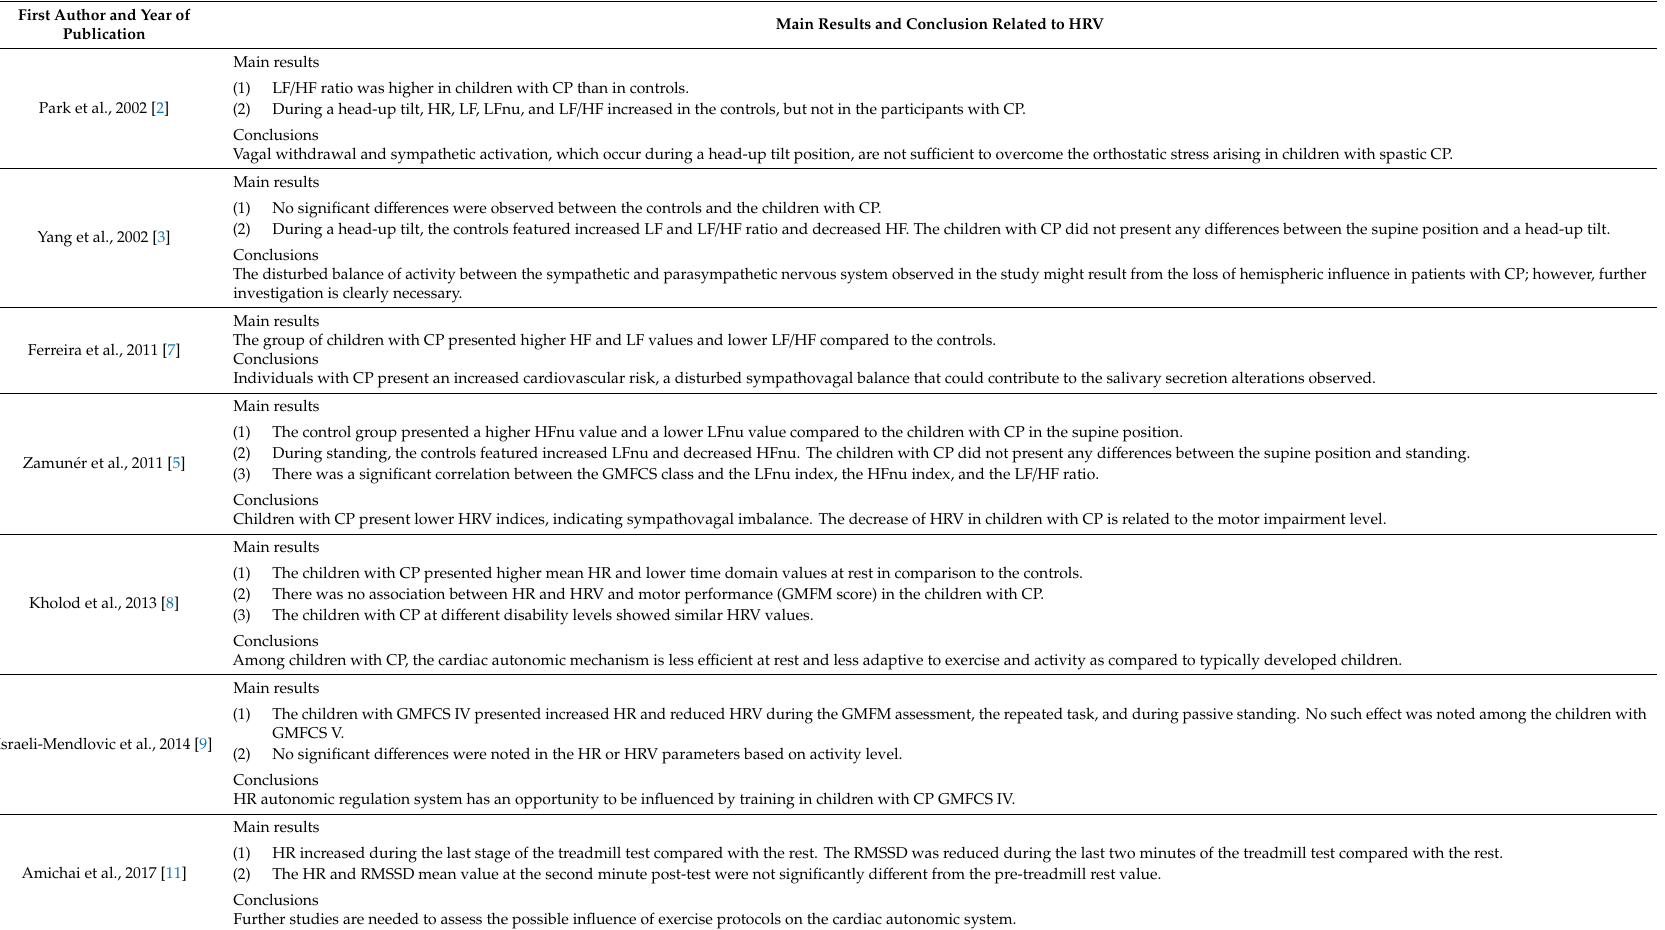
Table 3. Main results and conclusions from included